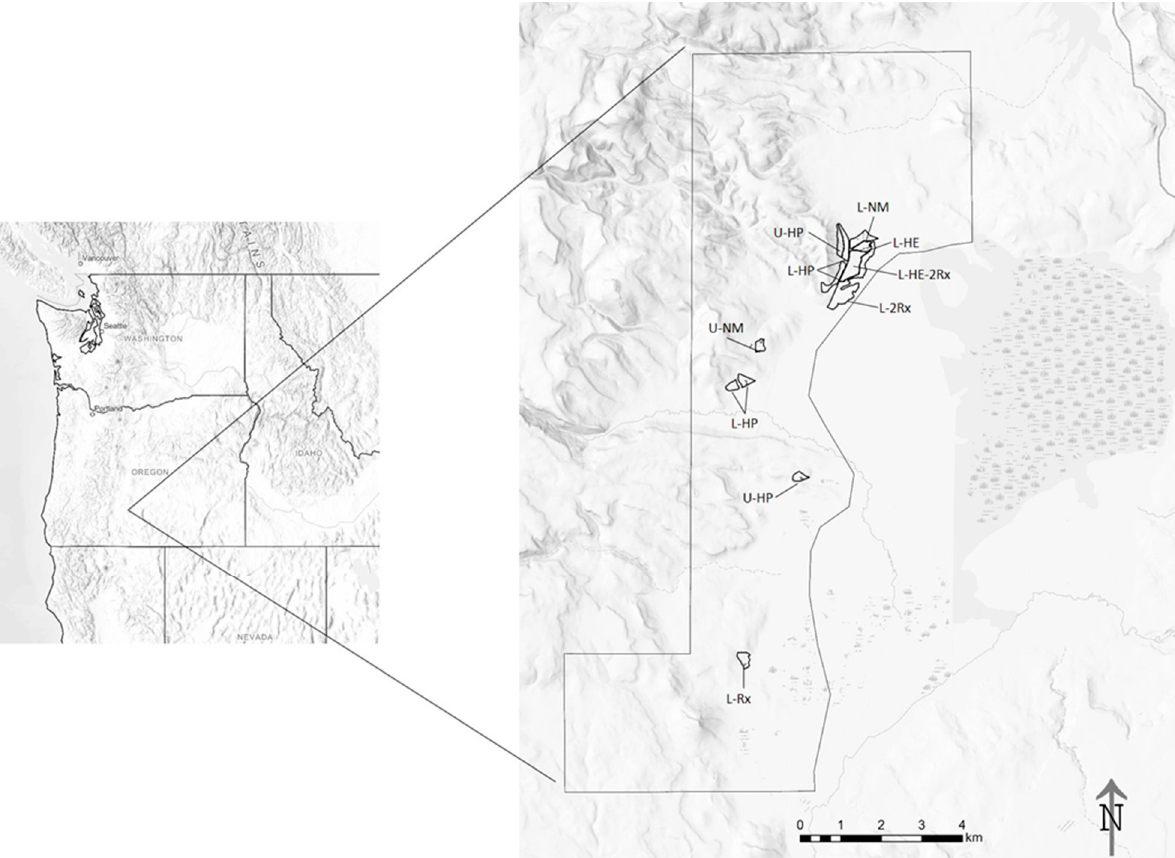
Figure 1. Map of our study area (8824 ha) in south–central Oregon. Elevations ranged from 1520 m to 1719 m. Locations of stands in the study area where trees were sampled are presented in the large-scale map on the right. Key to stand codes: L = lowland, U = upland, HE = harvest, even spacing, HP = harvest, patchy (clumps and openings), Rx = prescribed fire, NM = no management, no harvest or fire.